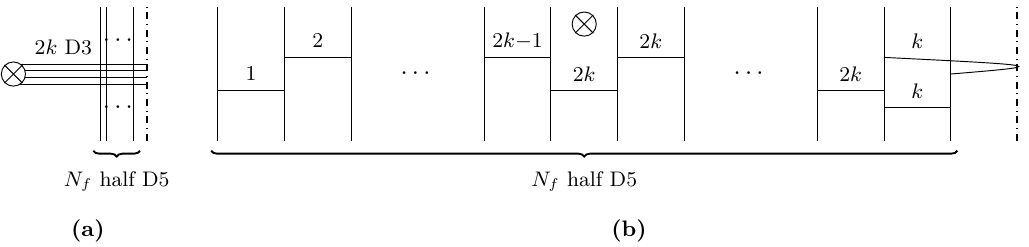
Figure 1. Brane configuration for 3d Sp( k ) with N f fundamental flavours. (See (A.2) for notations.) In (a), the brane configuration is in the electric phase or Coulomb branch phase, in which all D3s are suspended between NS5 branes. To transition to the Higgs branch phase, or magnetic phase, shown on (b), 2 k half D5s are moved through the half NS5 towards the left hand-side. The mirror theory is obtained from (b) via S-duality, i.e. exchanging D5 and NS5, and replacing the O 5 − with an ON −